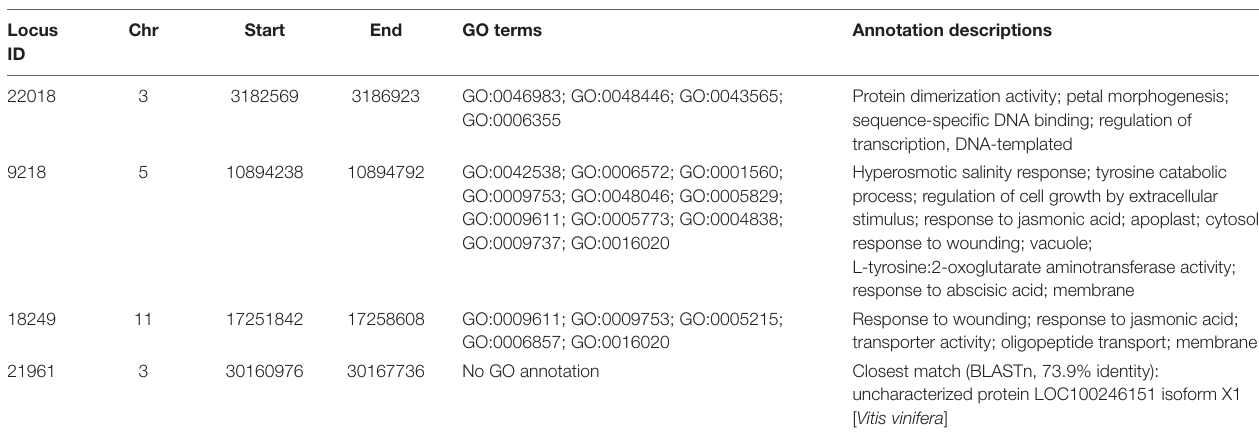
TABLE 7 | Annotations of genes coinciding with the private alleles listed in Table 6 . Locus Chr Start End GO terms ID